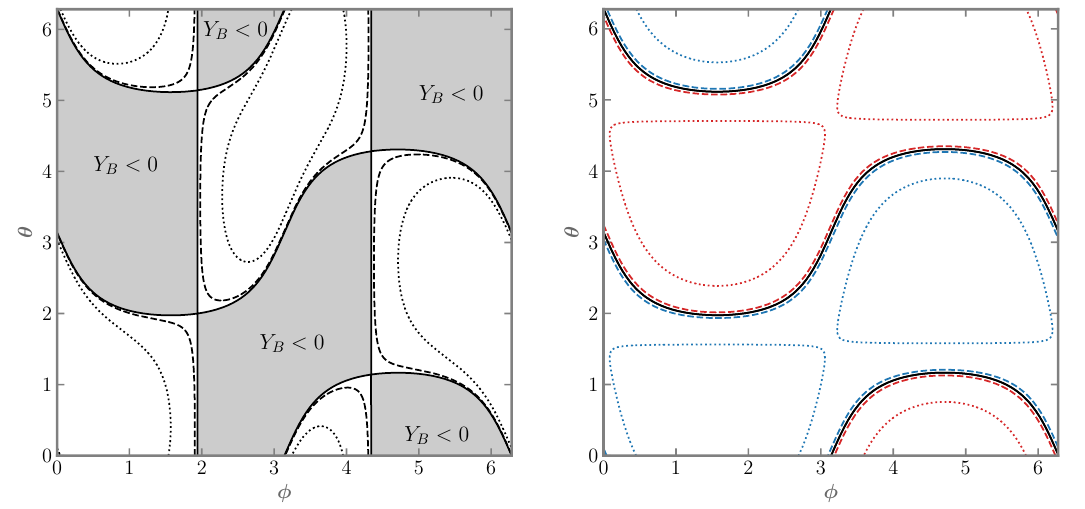
= (0 , 0 . 1 , 1) (solid, dashed, dotted). Grey LNC = ˜ f e / 2 = (0 . 01 , 0 . 1) . The black solid line IH IH